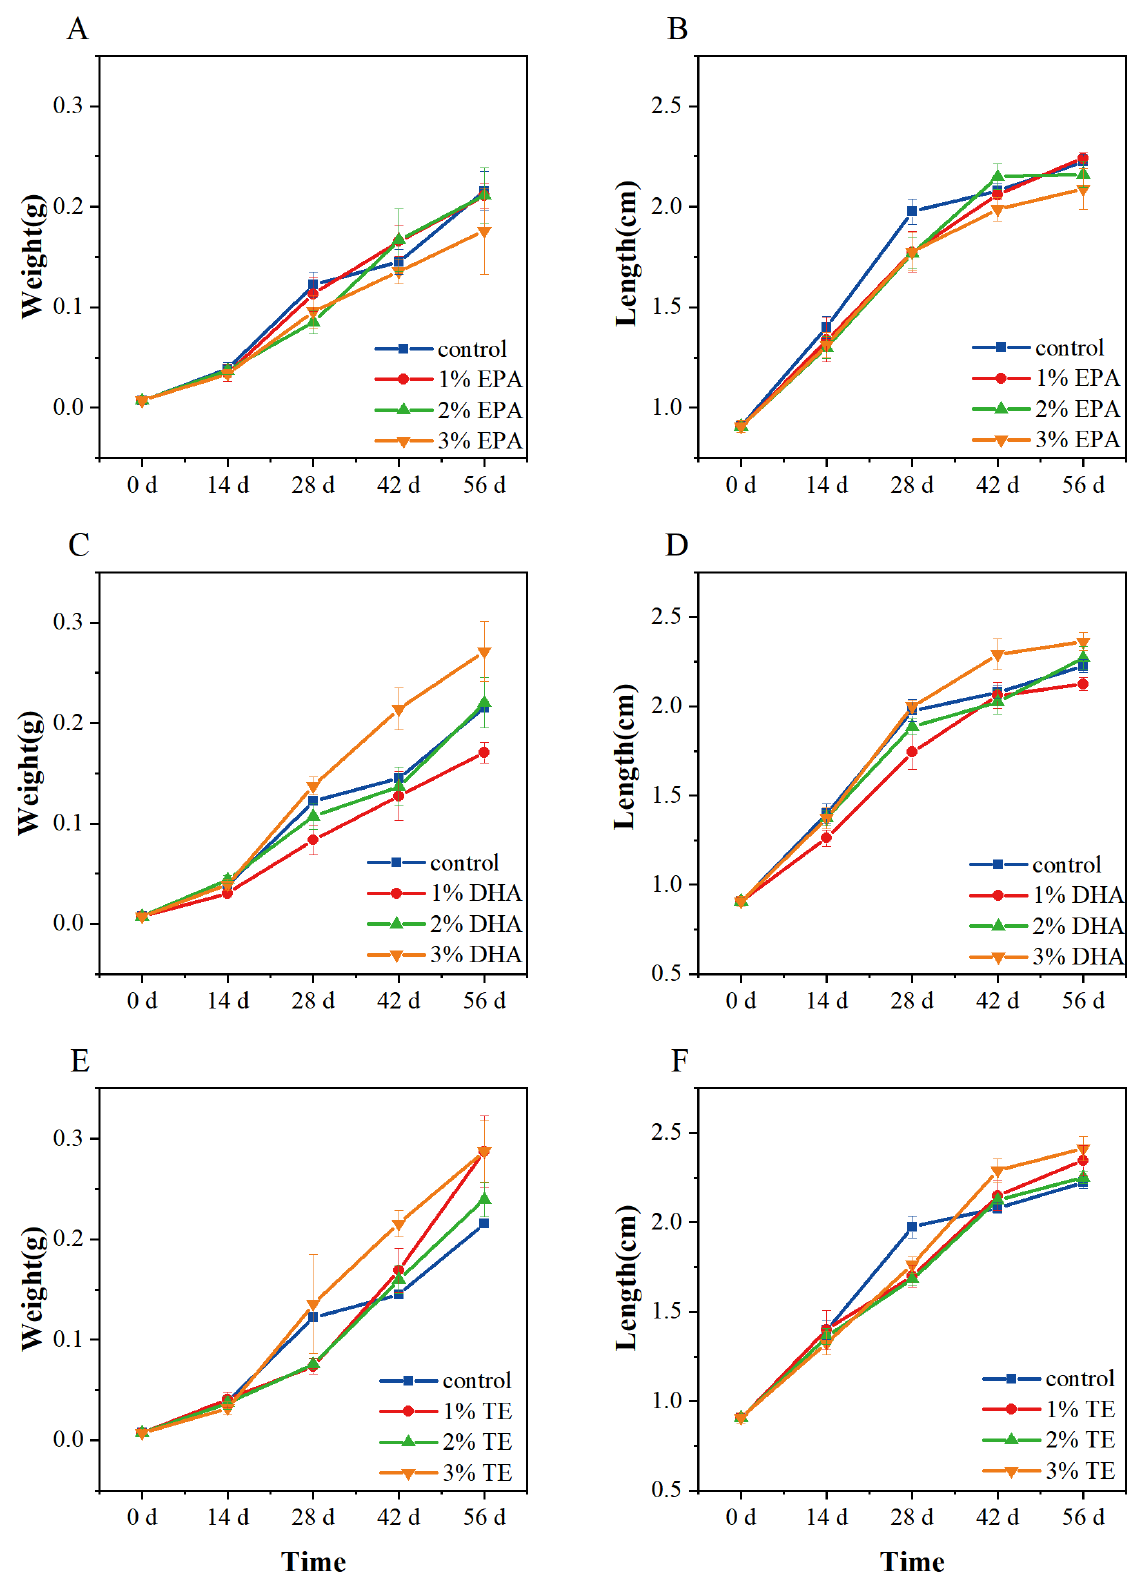
Figure 1. Effect of different diets on body weight and length of zebrafish. Growth data of dietary EPA group ( A , B ), dietary DHA group ( C , D ), and dietary TE group ( E , F ). Error bars indicate SEM ( n = 9). EPA: eicosapentaenoic acid; DHA: docosahexaenoic acid; TE: Aurantiochytrium sp. extract.